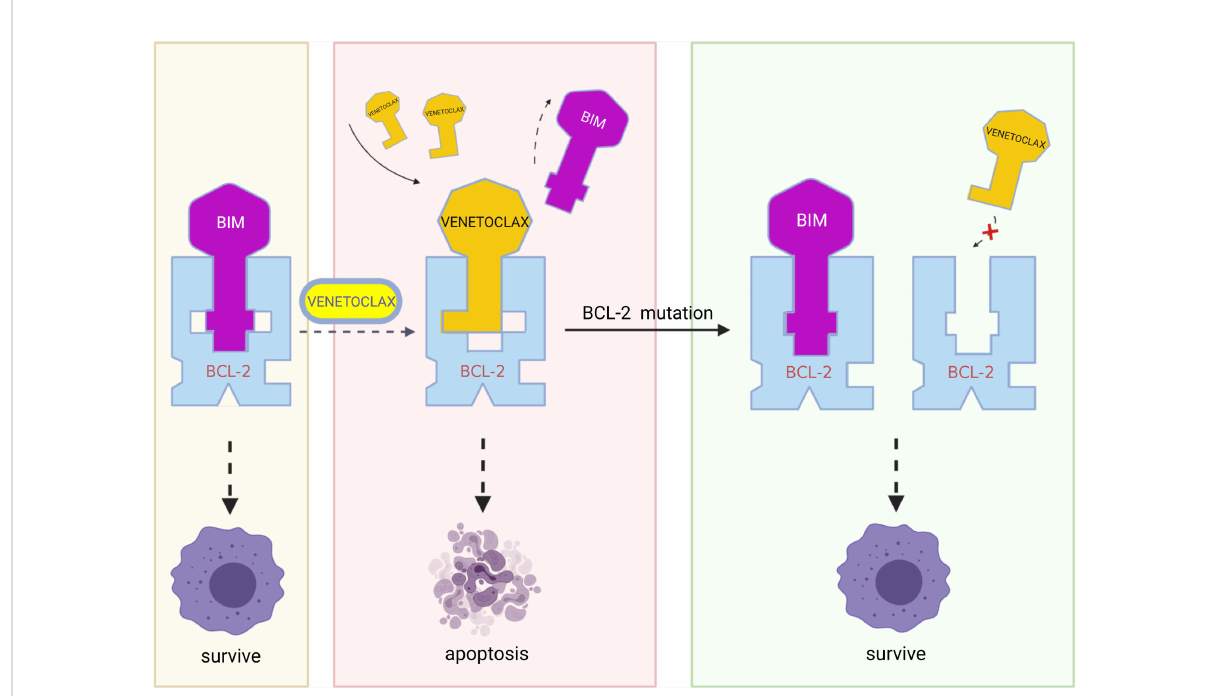
FIGURE 3 In resistant cells, multiple mutations in BCL-2, such as Gly101Val, Phe101Cys, Phe101Leu, and Aps111Ala, may result in decreased af fi nity of the BCL-2 protein for venetoclax while retaining the binding of BCL-2 protein to BIM and therefore blocking the action of venetoclax. (Created with